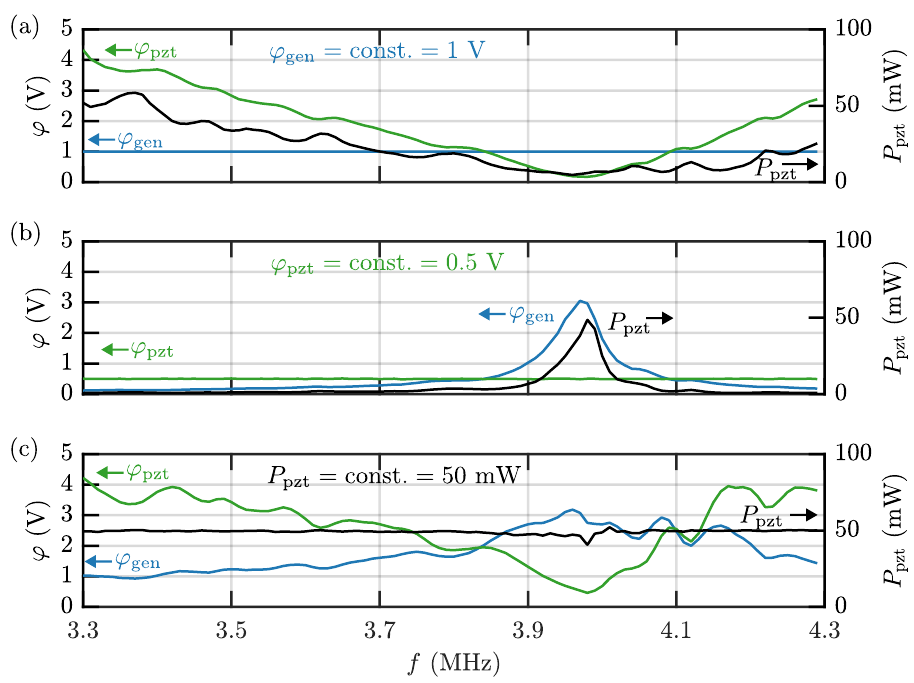
Figure 3. The measured voltage amplitudes ϕ pzt (green, left axis) and ϕ gen (blue, left axis) as well as the measured average power dissipation P pzt (black, right axis) plotted versus frequency for 3.3–4.3 MHz for the three cases ( a ) constant voltage ϕ gen at the signal generator, ( b ) constant voltage ϕ pzt across the piezoelectric transducer, and ( c ) P pzt constant average power